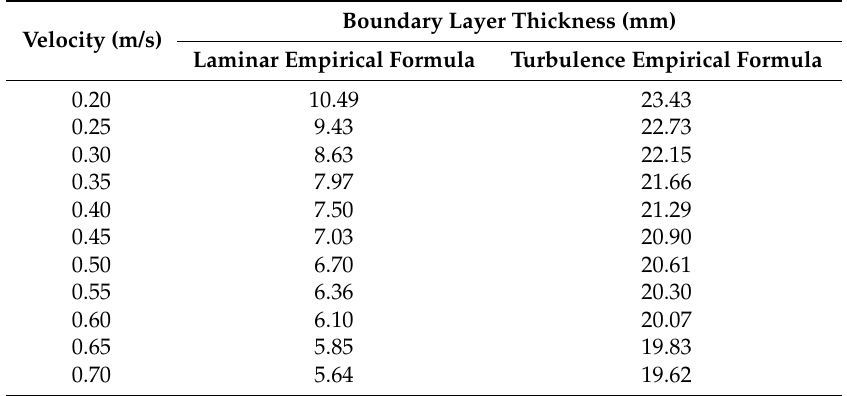
Table 2. Boundary layer thickness calculated by empirical formulas (x = 804mm).